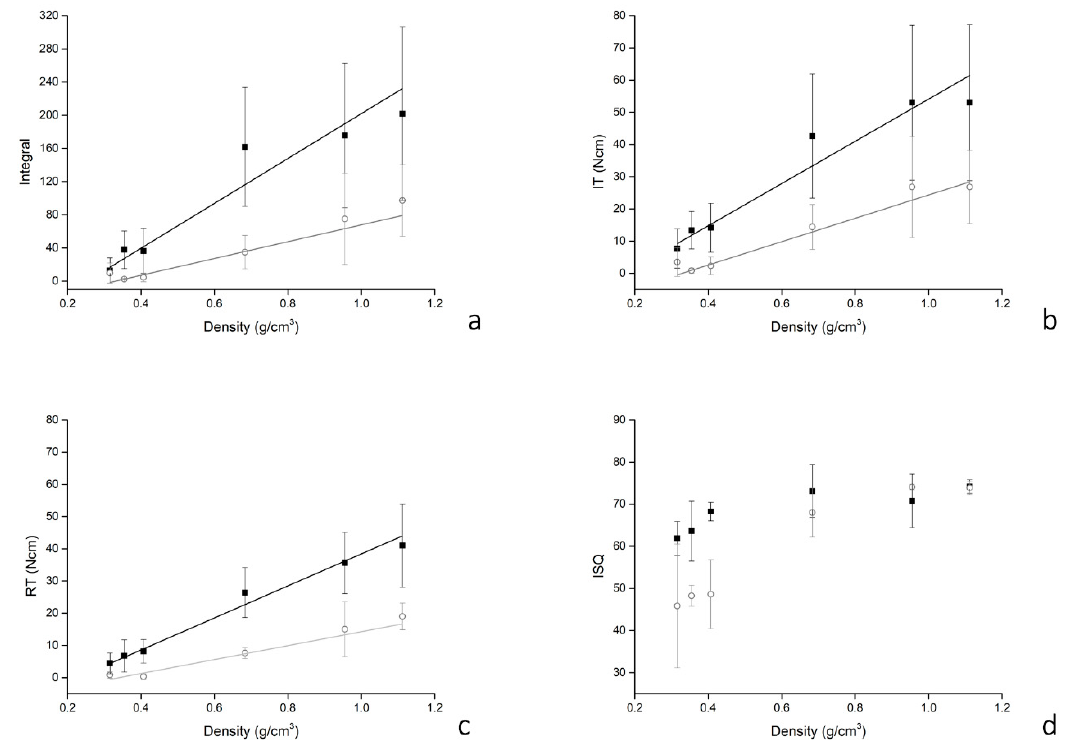
Figure 5. Plots showing how primary stability measurements, that is the ( a ) torque–depth curve integral, ( b ) the insertion torque (IT), ( c ) the reverse torque (RT), and ( d ) the implant stability quotient (ISQ) varied with density. Superimposed lines are those achieved by linear regression analysis. The slope of the integral–density curve (see values on y-axis in plot (a)) is greater than those of IT-density and RT-density, indicating that the integral is more sensitive to density variation than the other two parameters. The ISQ-density plot shows an altogether different shape (see text for comment). Table 2. Spearman’s r coefficients measuring the correlation between the integral (I), the insertion torque (IT), the reverse torque (RT) and the implant stability quotient (ISQ) recorded at implant placement without irrigation (above the diagonal) and with irrigation (below the diagonal). Significant values are marked with an asterisk (*) and statistical significance is shown in italic.